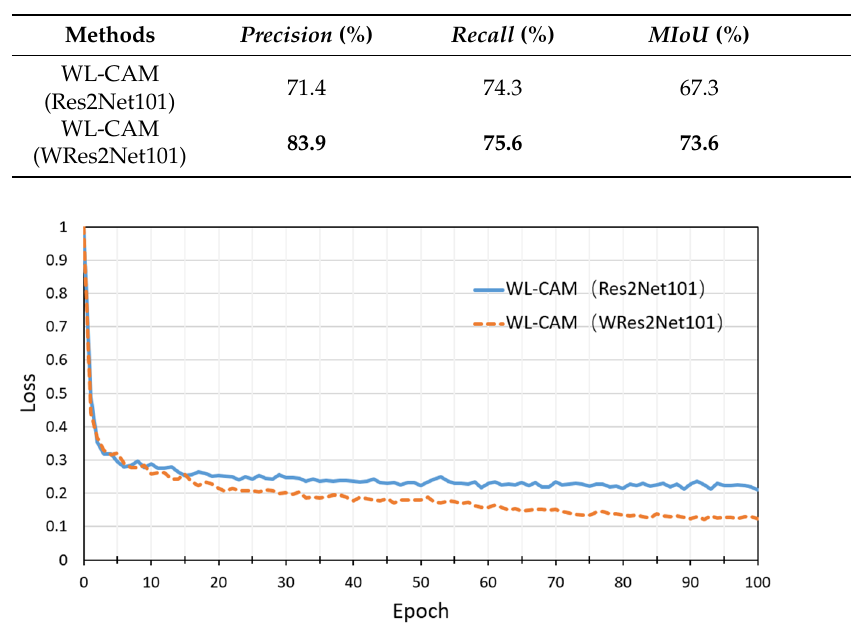
Figure 7. Loss of WL-CAM with different backbone networks.